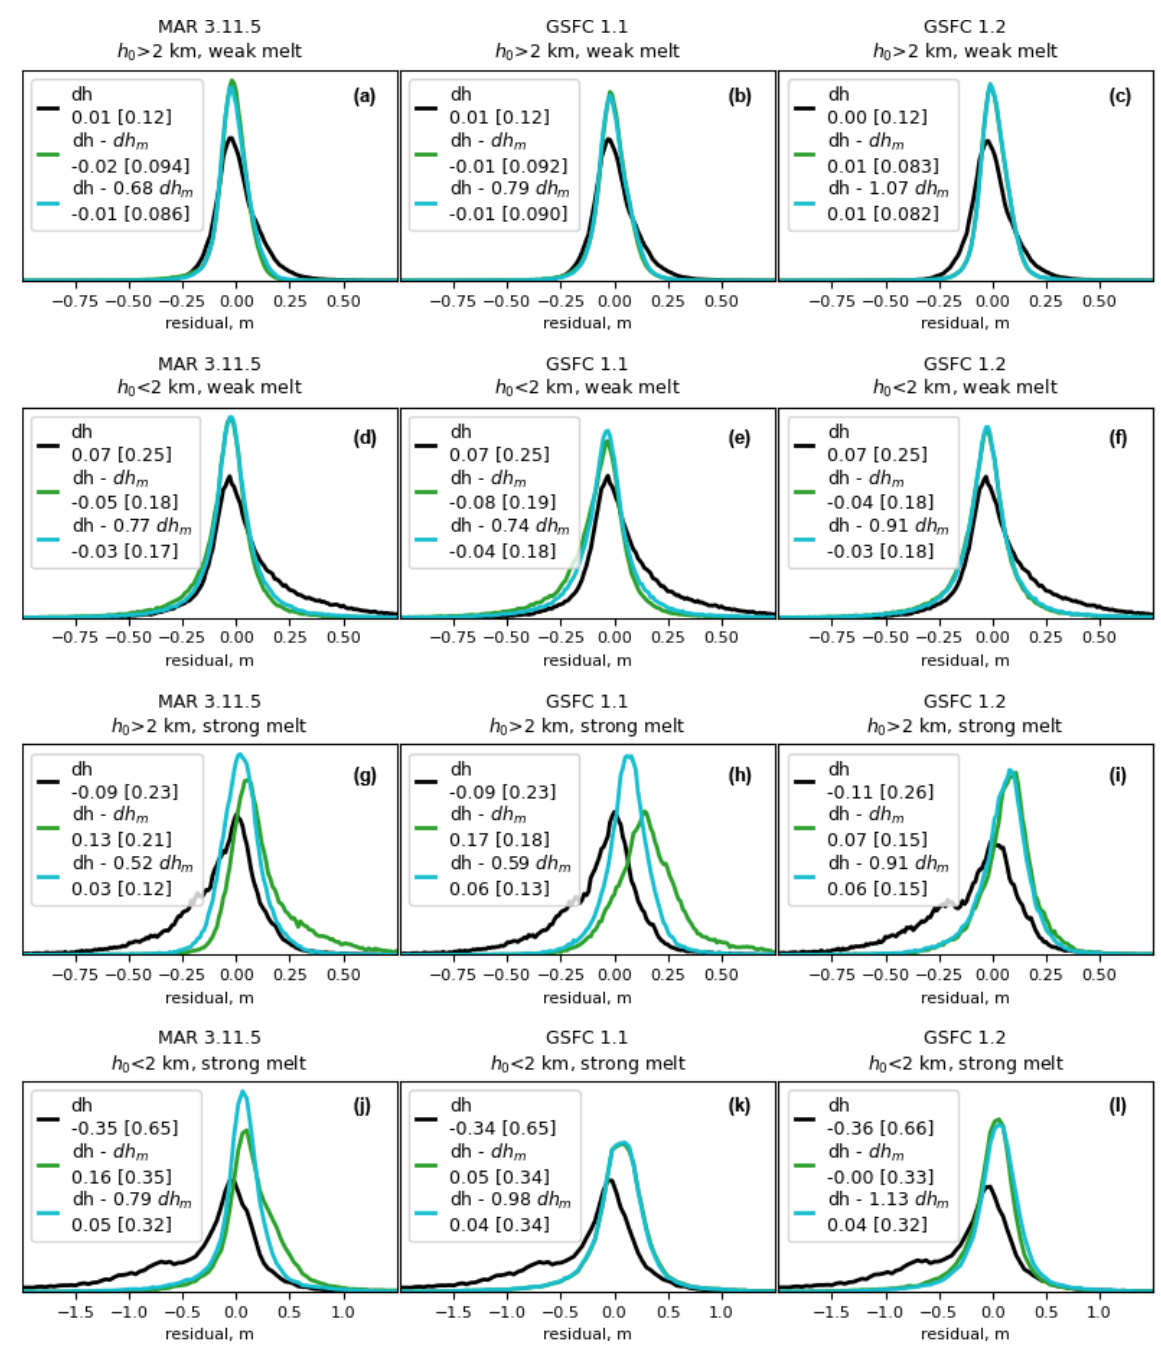
Figure 7. Height-difference and residual histograms for subsamples of the data based on height and model estimates of melt and SMB. The curves in each plot represent measured height change (black, dh ), height change corrected by the total model (green, dh − dh m ), and height change corrected by the model scaled by [ A ] (blue, dh - [ A ] dh m ). Vertical axis units are arbitrary, but the areas under the curves in each panel are the same. Panels (a) – (c) show data from high elevation ( h 0 > 2km) with weak melt ( z melt < 0 . 2 | dh m | ) for the three models. Panels (d) – (f) show data from low elevation ( h 0 > 2km) with weak melt. Panels (g) – (i) show data from high elevation ( h 0 > 2km) with strong melt ( z melt < 0 . 2 | dh m | ). Panels (j) – (l) show low elevation with strong melt. Legend labels follow the format used in Fig. 5.